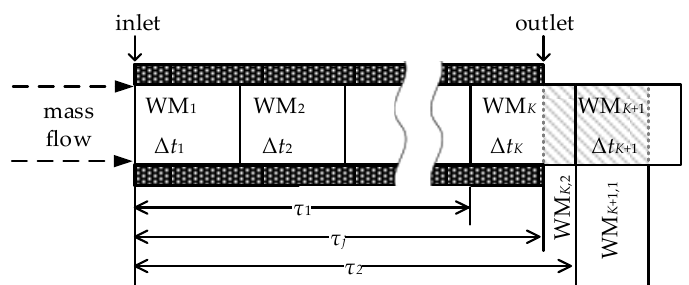
Figure 3. Vertical section of the thermal pipeline.